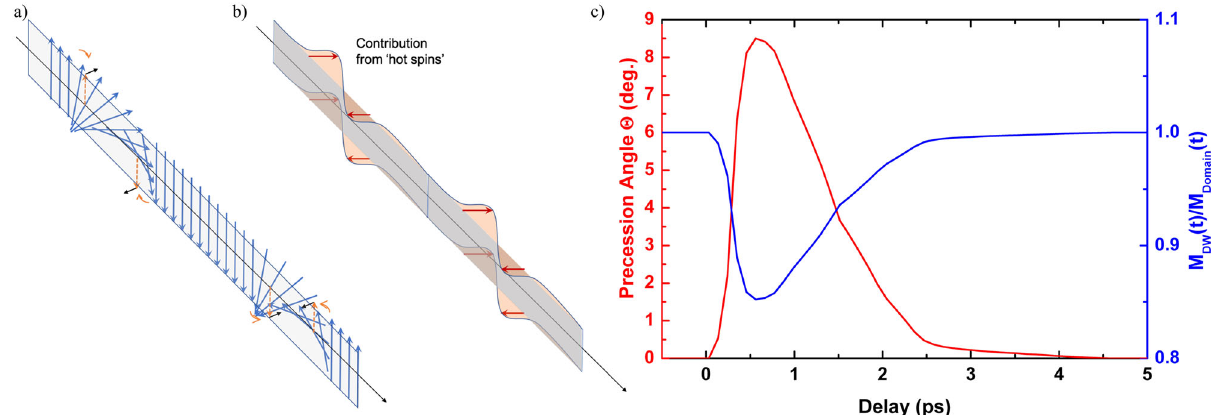
Fig. 3 Magnetization texture modi fi cation by hot electrons. a Schematic representation of the torque (black arrows) imposed by the “ hot spins ” fl owing from the domains to the DWs resulting in transient mixed Bloch/Néel/Bloch contributions. b Transient DW shape. c Precession angle (red) and DW magnetization normalized by the one from the domain (blue) used in the simulations of the asymmetry ratio shown in